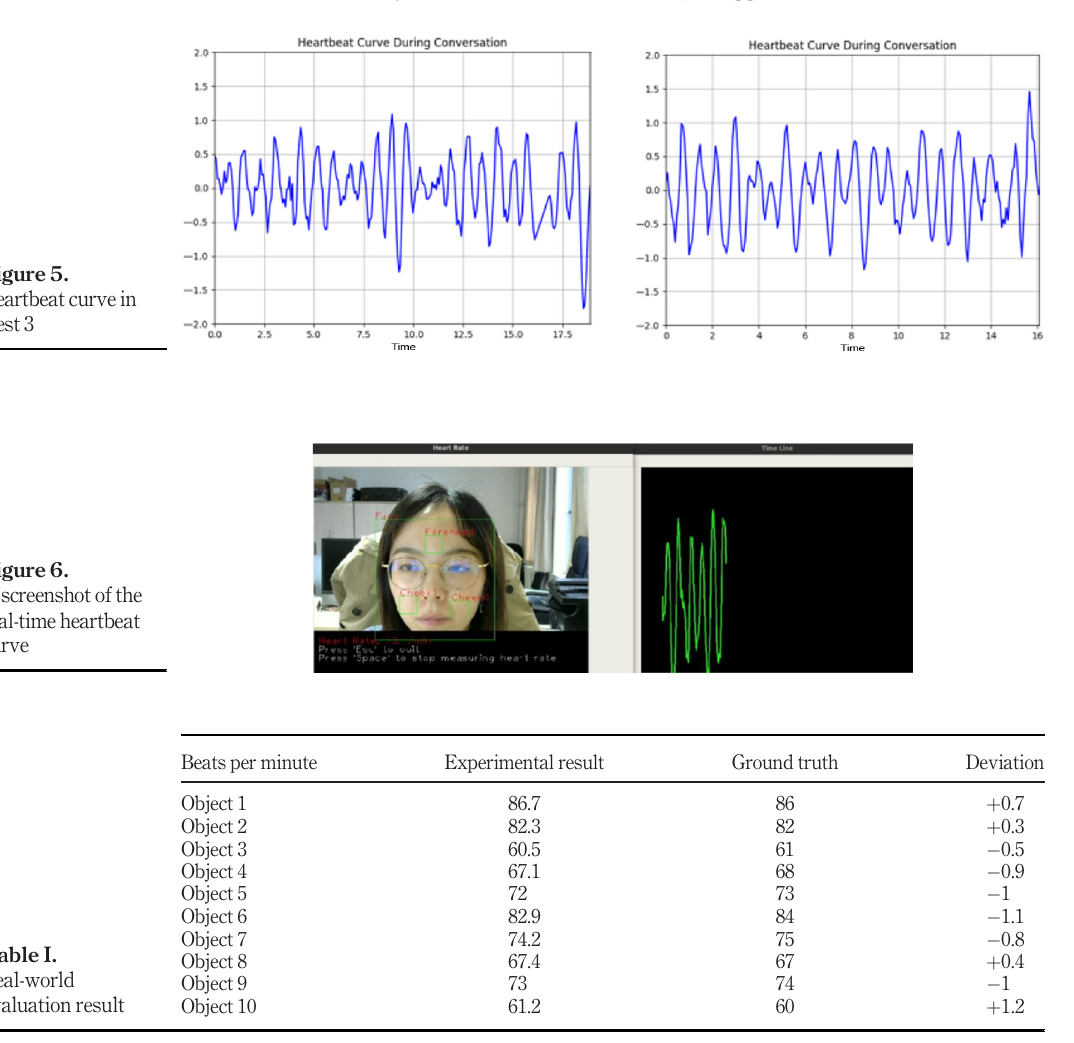
Beats per minute Experimental result Ground